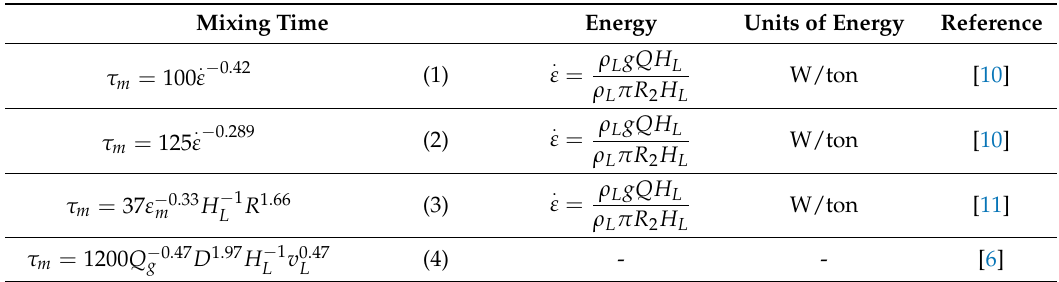
Table 1. Mixing time correlations for baths without an upper layer.